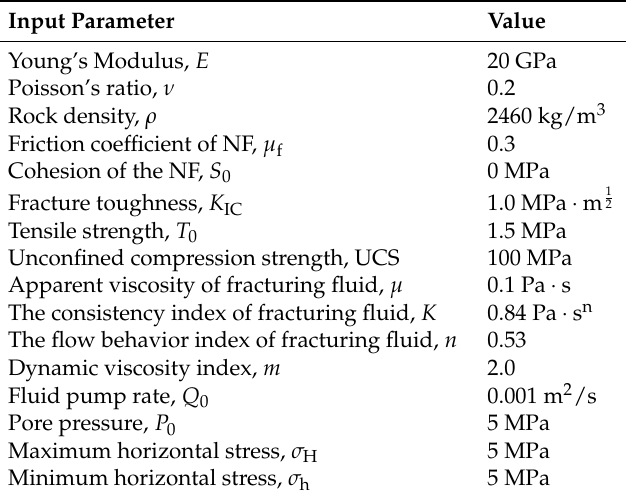
Table 1. Input parameter values of the hydro-fracking